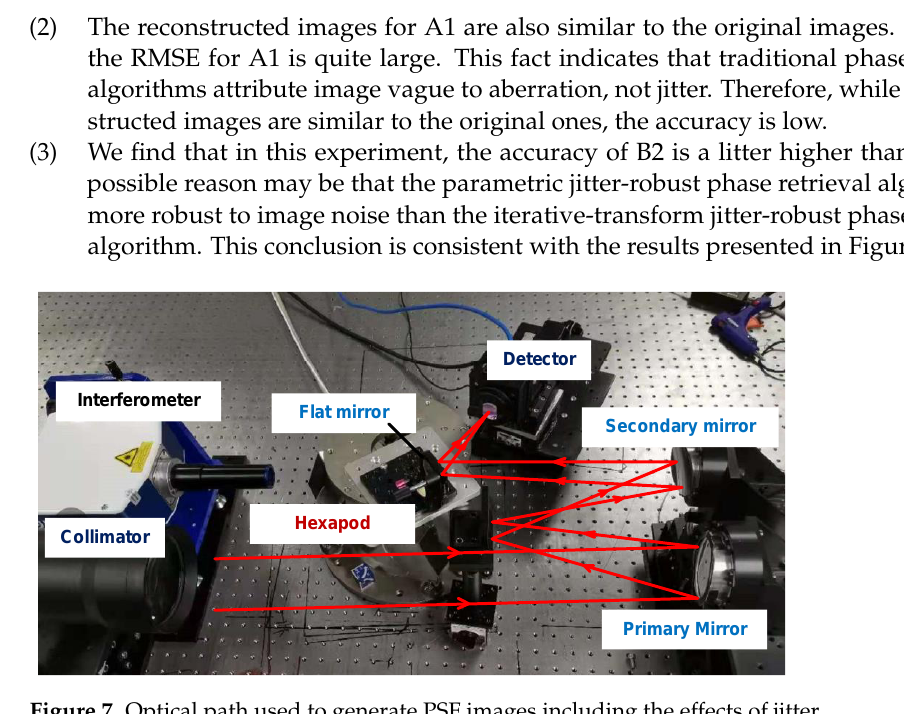
Figure 7. Optical path used to generate PSF images including the effects of jitter.